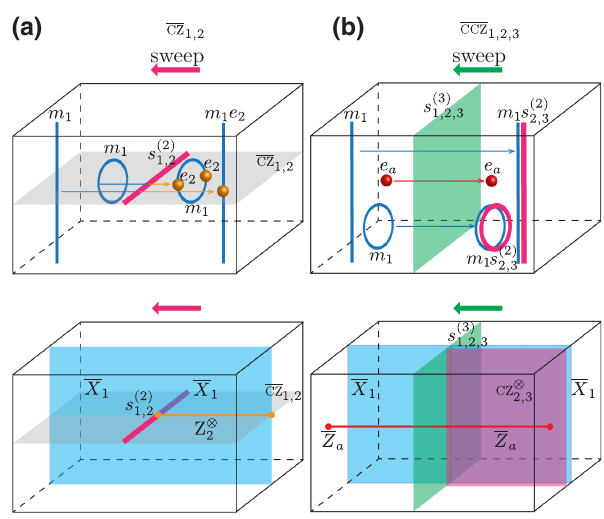
FIG. 26. (a) Sweeping the CZ domain wall s ( 2 ) (pink) across 1,2 a noncontractible codimension-1 submanifold M 2 (gray) gives rise to a transversal logical gate CZ 1,2 applied along this subman- ifold. When passing the m 1 -string (loop) in copy 1 across the wall , a new particle e 2 (orange) in copy 2 is generated at the inter- s ( 2 ) 1,2 section point. Therefore, a logical brane X 1 is transformed into (yellow), which the product of itself and an additional string Z ⊗ 2 becomes the logical string Z 2 when the sweeping is completed, as illustrated in the lower panel. (b) Sweeping the codimension- across the system gives rise to the 1 CCZ domain wall s ( 3 ) 1,2,3 transversal logical gate CCZ 1,2,3 . An m 1 -string (loop) gets trans- -string (loop) when passing across the wall. formed to an m 1 s ( 2 ) 2,3 Therefore, a logical brane X 1 is transformed into the product of (pink), which becomes the itself and an additional brane CZ ⊗ 2,3 logical brane CZ 2,3 when the sweeping is